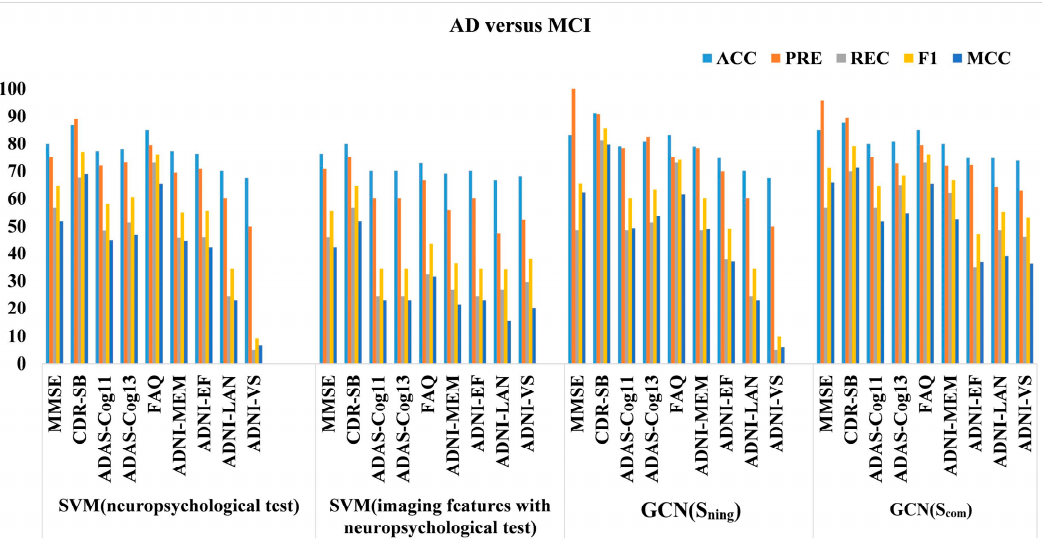
Figure 5. Performance comparison using graph features or vector features on the test data for AD versus MCI task.